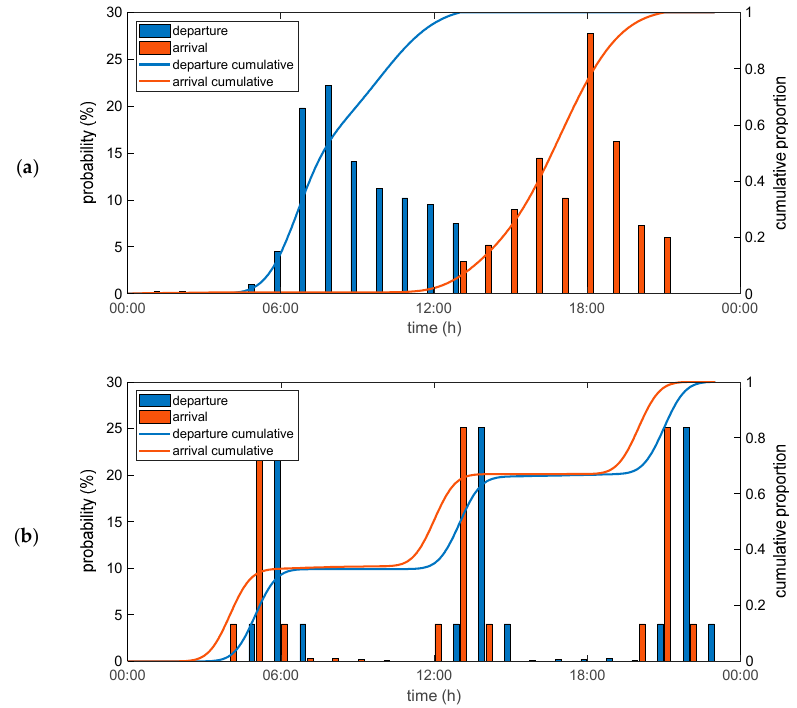
Figure 1. Original destination matrices according to Bosserhoff [23] and cumulative distribution function ( a ) trip home; ( b ) trip to work—shift operation. Reproduced from [11].